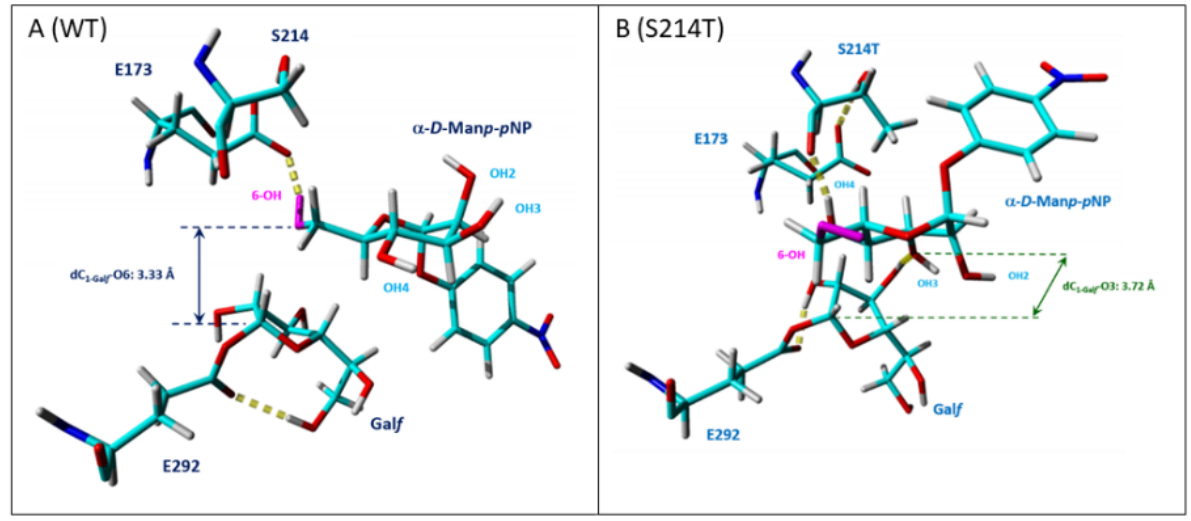
Figure 7. Ct Ara f 51 WT ( A )/ Ct Ara f 51 S214T ( B )-Gal f complexes interacting with Man p - p NP after MD. Man p - p NP was initially (1 → 6) oriented. (Man p (6-OH) are highlighted in magenta; stackable complexes with a RMSD: 1.3303 Å on 7991 matched atoms).